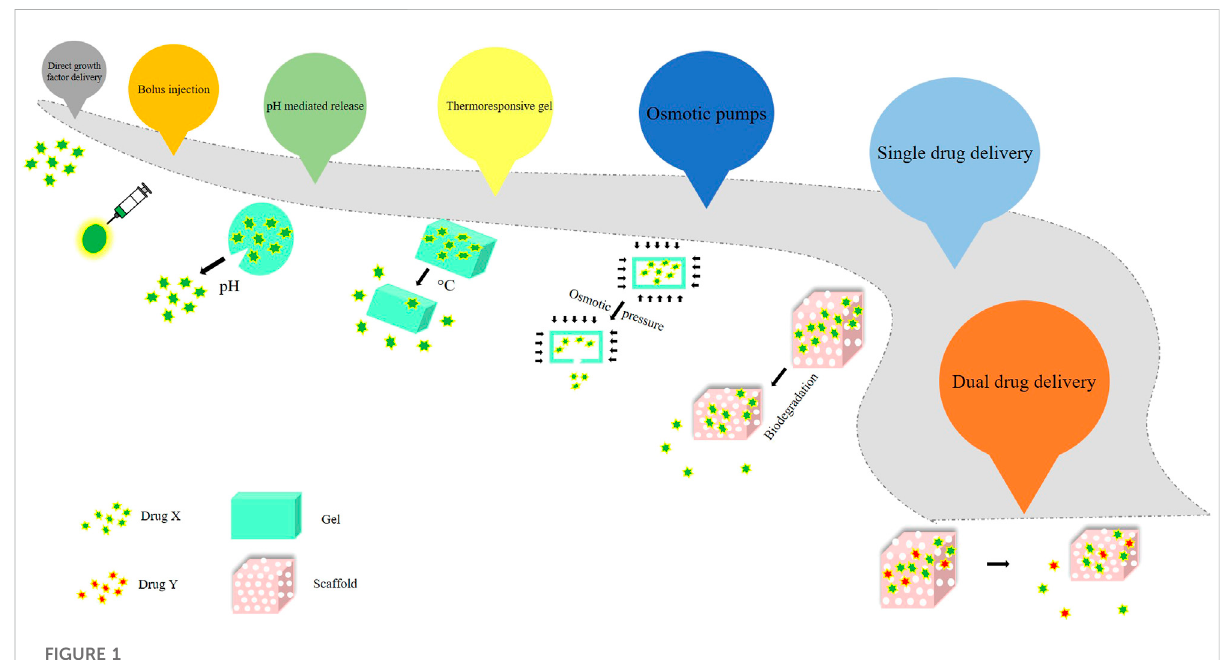
FIGURE 1 Evolution of drug delivery over